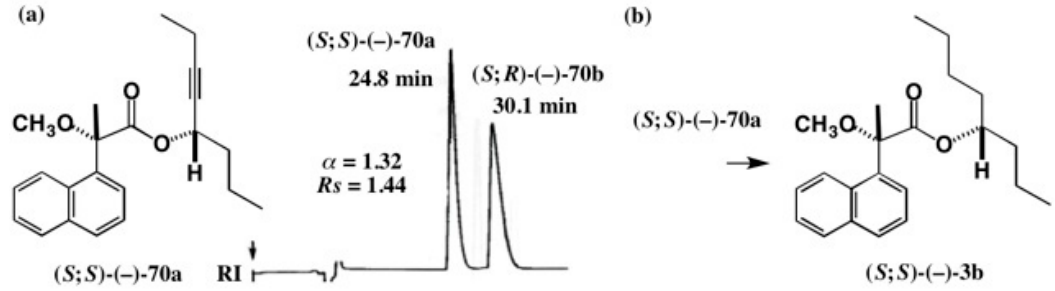
Figure 51. HPLC separation of diastereomeric 5-octyn-4-ol M α NP esters, and conversion to 4-octanol M α NP ester by catalytic reduction: ( a ) 70a / 70b , hexane/EtOAc 20:1, reprinted with permission from [60]; ( b ) Reduction with H2/PtO2 in diethyl ether.